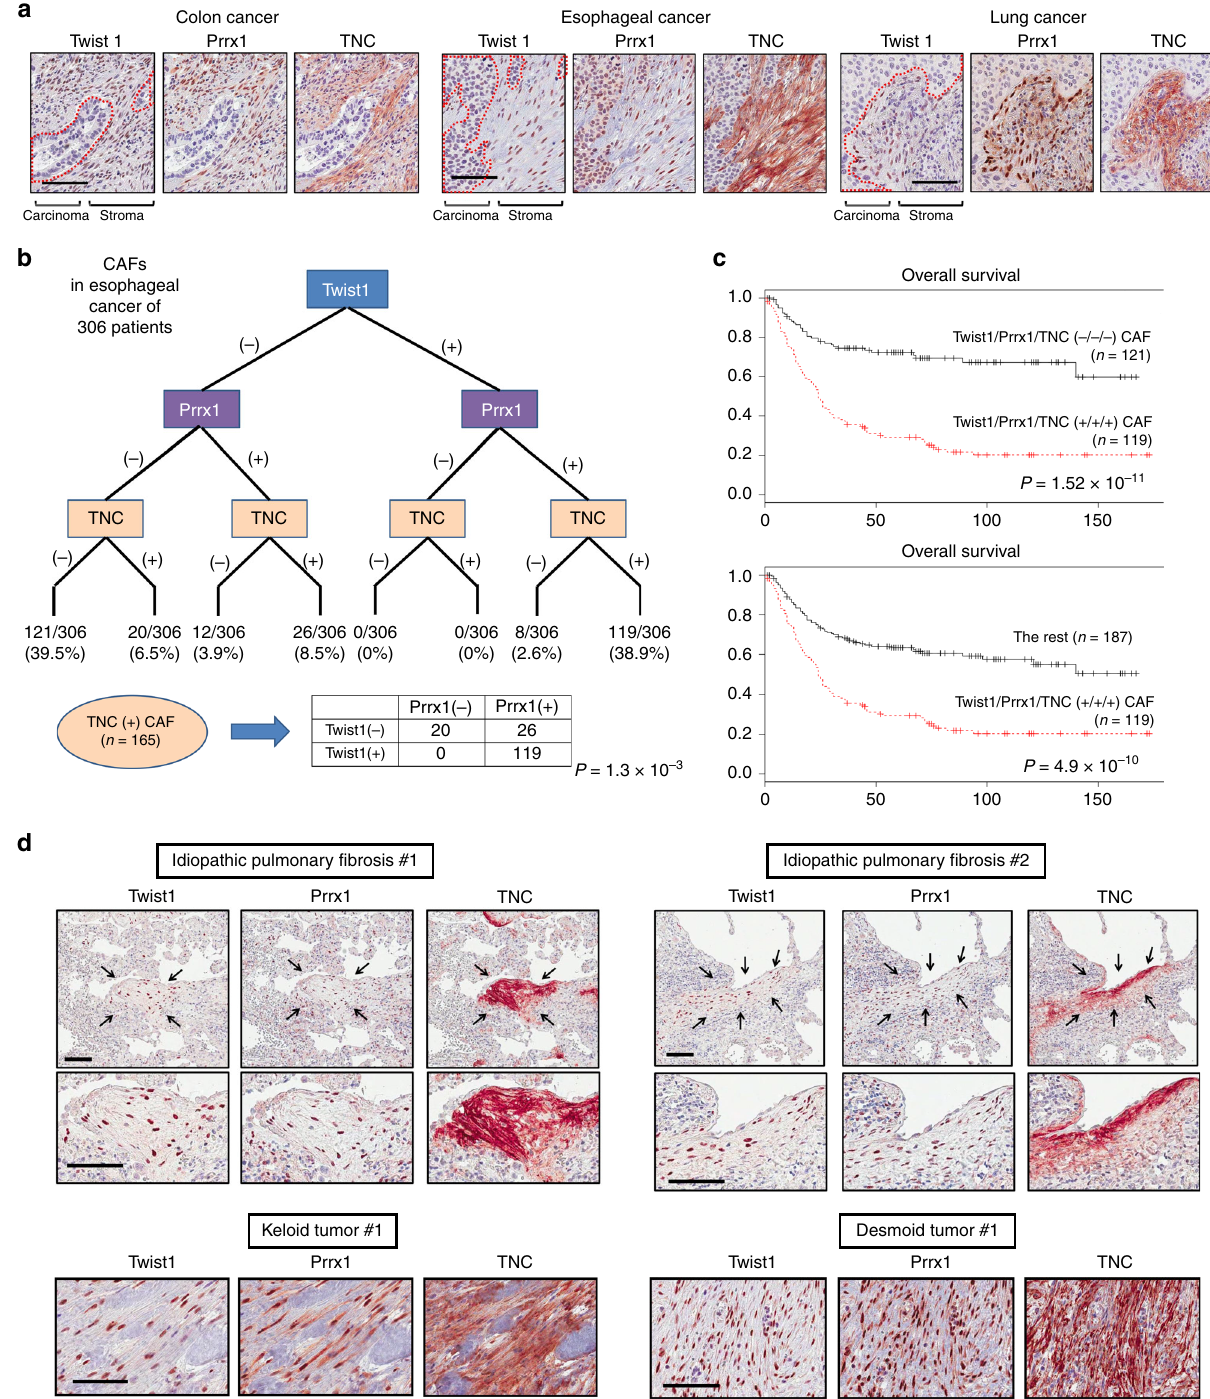
Fig. 8 The coexpression of Twist1, Prrx1, and TNC is frequently found in cancer-associated fi broblasts and pathologic fi brosis. The clinical implications of the Twist1-Prrx1-TNC PFL in CAFs and fi brotic diseases. a , b We examined the coexpressions of all three genes by mIHC (scale bar indicates 100 μ m). The bimodal distribution of the triple gene expression, all positive vs. all negative, a hallmark of a bistable system, was evident again in esophageal CAFs. These data are highly consistent with the computational prediction that the Twist1-Prrx1-TNC PFL functions may lead to irreversible and perpetual activation in pathologic conditions. We analyzed the expression pro fi les of these three genes in 306 esophageal cancer tissues. c The presence of CAFs that were positive for all three genes was strongly associated with the worse clinical outcomes. d Fibroblasts that were positive for all three genes were frequently observed in pathologic fi brosis, such as idiopathic pulmonary fi brosis, keloid disease, and desmoid tumors (aggressive fi bromatosis). Scale bar